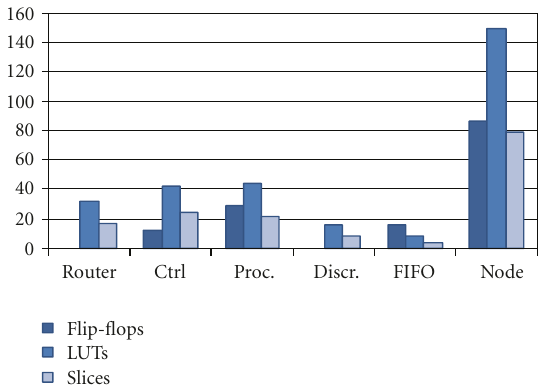
Figure 21: Area utilization of the di ff erent components with serial broadcasting scheme.